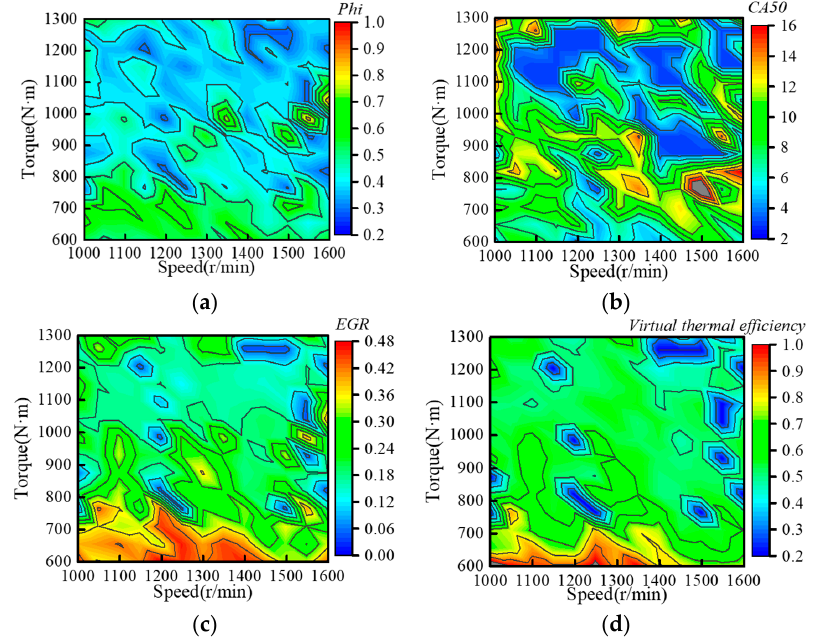
Figure 13. ( a ) Phi ( b ) CA50 ( c ) EGR ( d ) Virtual thermal efficiency. Optimal results based on fish swarm algorithm .